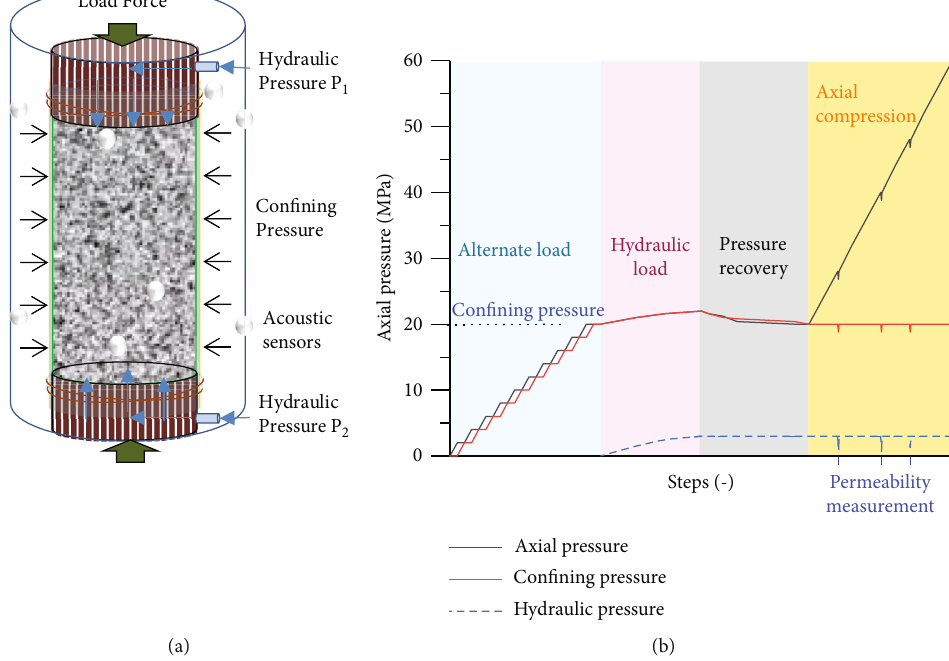
Figure 1: Schematic diagram of (a) the hydromechanical coupled triaxial compression experiment and (b) loading